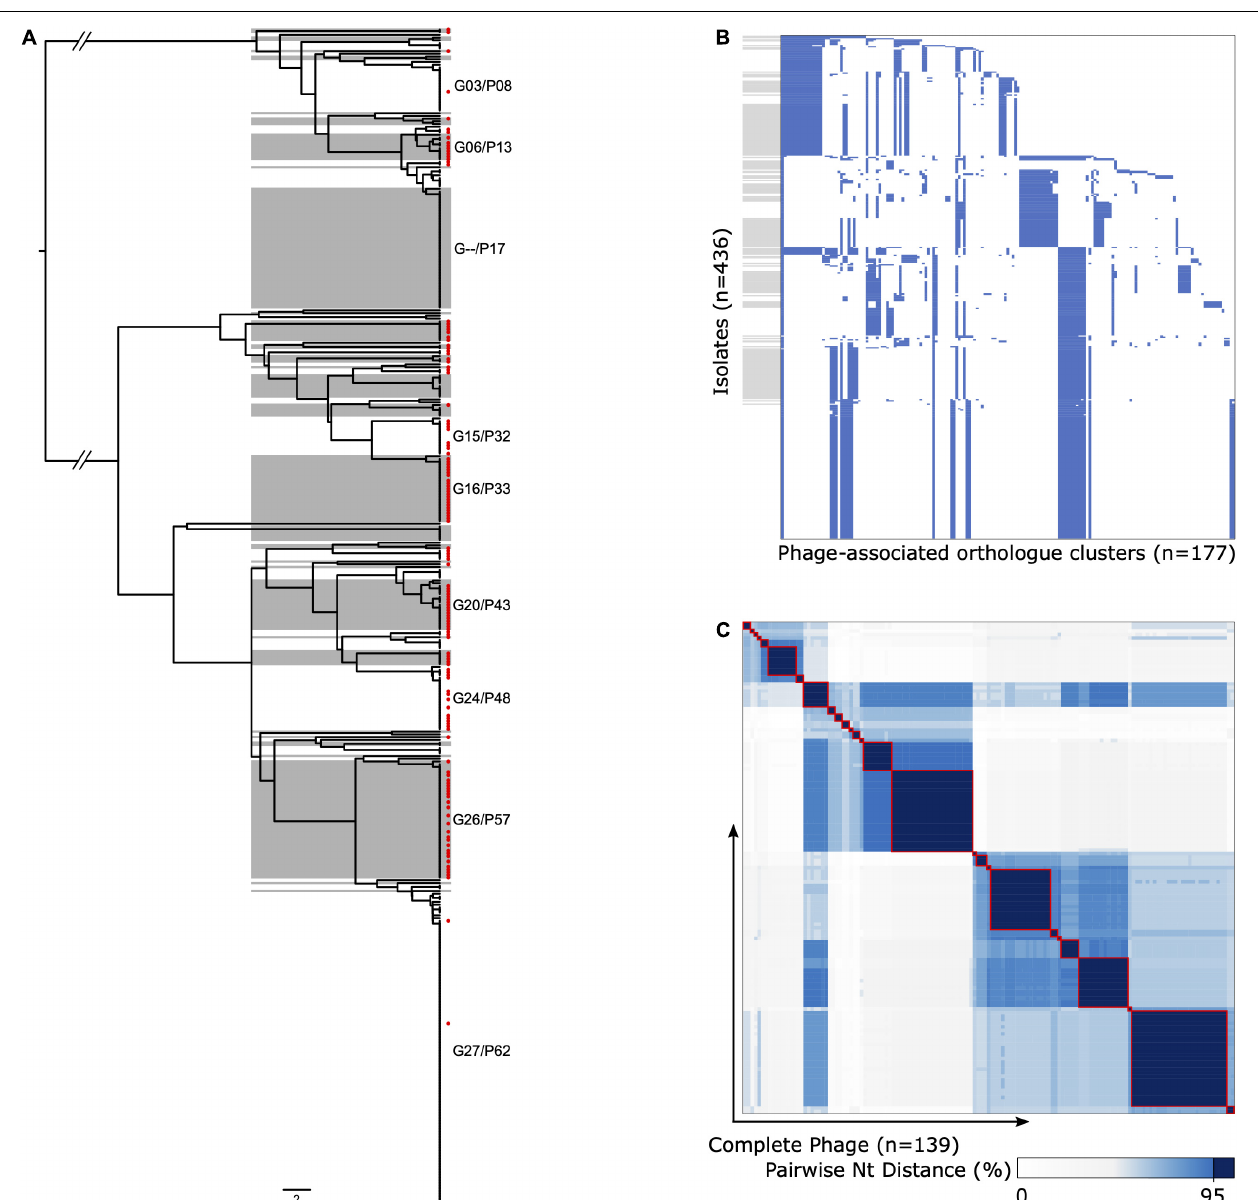
FIGURE 3 | Diversity and population structure of (cid:56) ETA. (A) Phage gene tree (scale = 2/177 genes) illustrating the clustering of (cid:56) ETA. Alternating gray/white shading indicates phage phylogroups based on the presence/absence of gene ortholog clusters, guided by the nucleotide identity of complete prophage sequences as described in the Methods . Red tip symbols indicate isolates with complete prophage sequences. Phylogroups with ≥ 10 representative are annotated on the tree. (B) Gene presence/absence matrix for all isolates used to generate gene tree (blue, present; white, absent). The y -axis is ordered by the phage tree order shown in panel (A) , and gray boxes align with phage phylogroups. The x -axis is ordered based on gene presence descending across tree. (C) Heatmap of pairwise nucleotide distances between the complete phage sequences [ n = 139, red tip labels in panel (A) ]. The gradient indicates percent nucleotide identity, with a consistent dark blue and red outline to highlight cluster with ≥